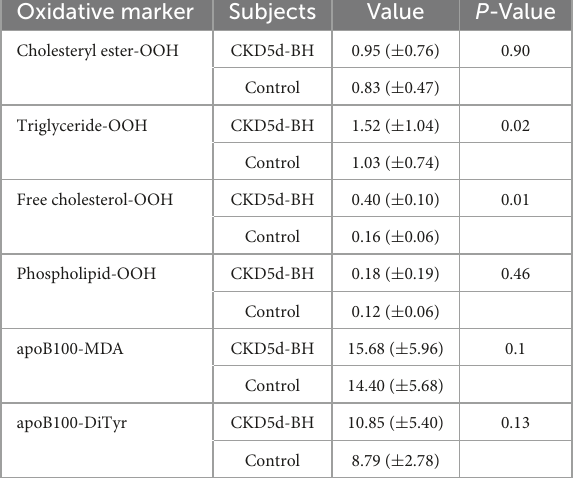
TABLE 6 Oxidation markers of LDL lipid sub-fractions and apoB100 in CKD-5d patients before hemodialysis versus the control group. Oxidative marker